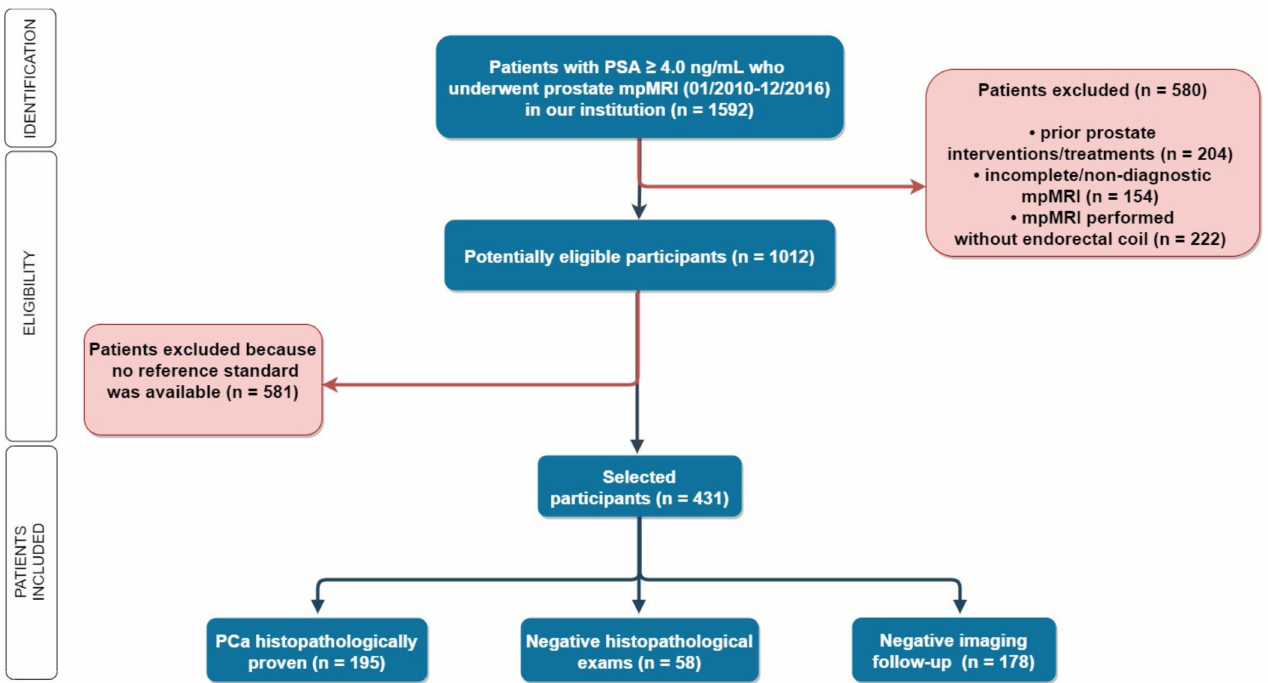
Figure 1. Flowchart: 1592 patients with elevated PSA levels ( ≥ 4.0 ng/mL) underwent mpMRI in our institution, and 431 patients were selected according to our inclusion and exclusion criteria. In 253 patients, a histopathological reference standard was available. PSA: Prostate-specific antigen, mpMRI: multiparametric MRI, and PCa: prostate